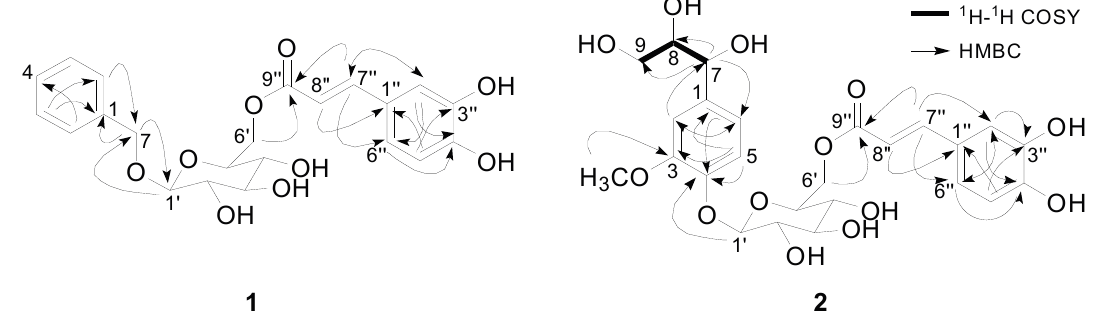
Figure 2. Key 1 H- 1 H COSY and HMBC correlations for Compounds 1 and 2